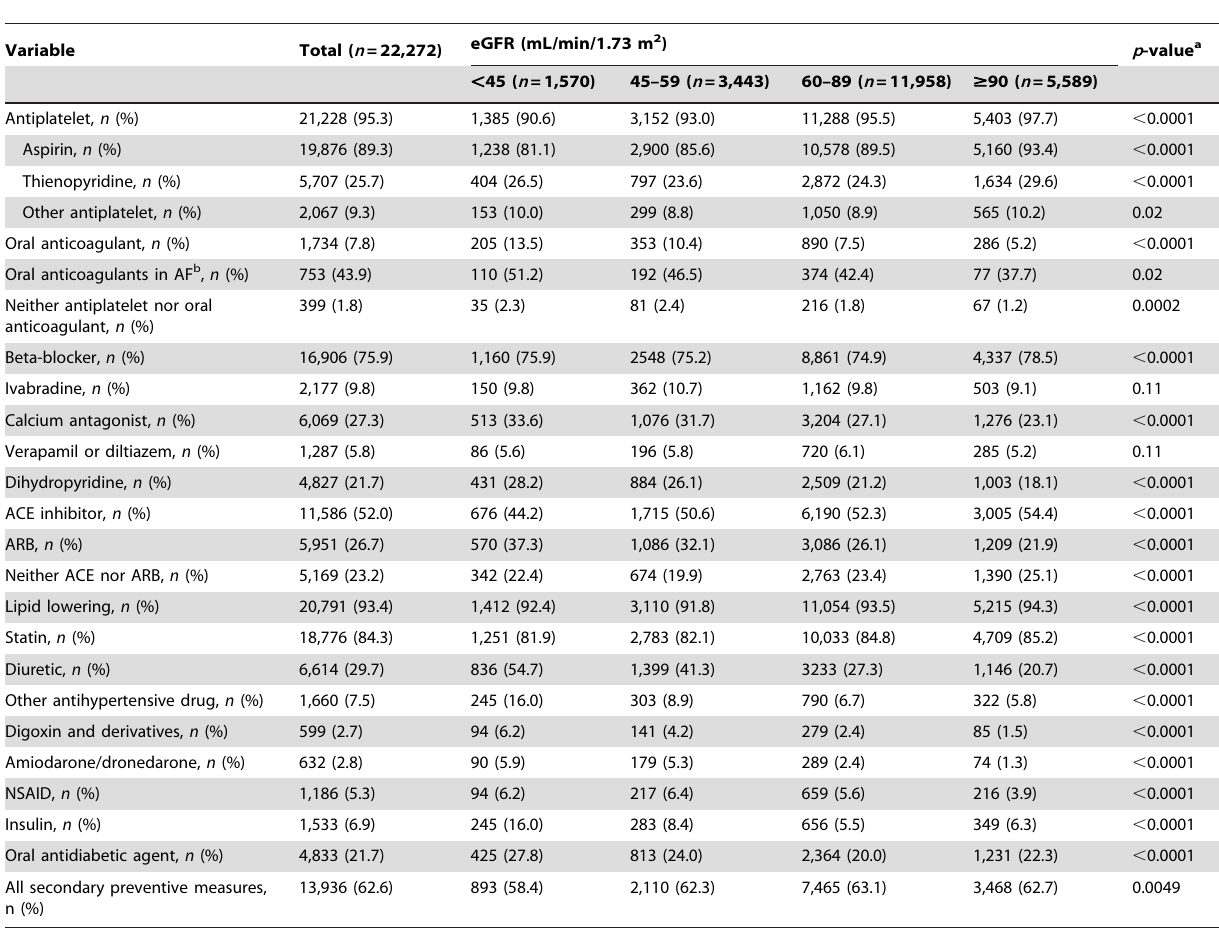
Table 3. Drug treatment for all patients with available data according to eGFR group calculated using the CKD-EPI.